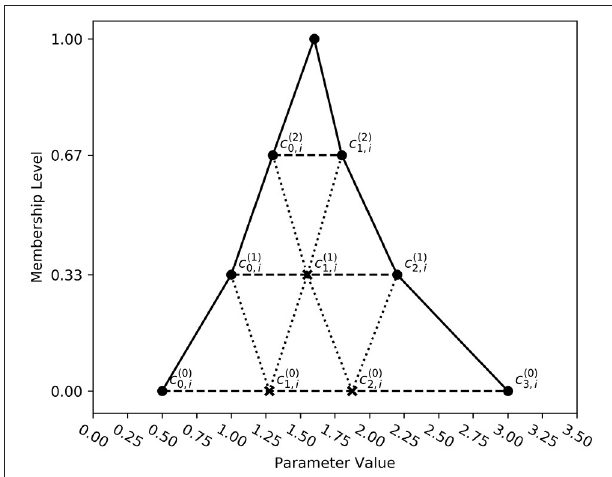
FIGURE 2 | Illustration of the discretization of a fuzzy number into array form using the transformation method. Adapted from Hanss (2005).